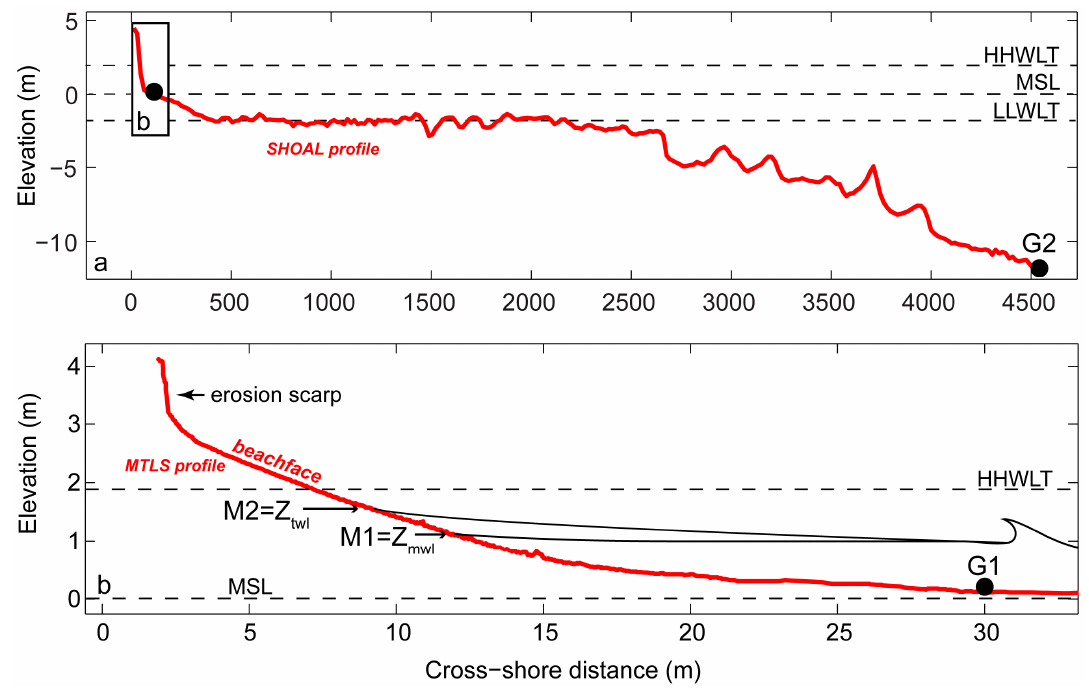
Figure 2. Cross-shore profile (extracted from a shoal survey of 2015 obtain from the Canadian Hydrographic Service, 2015) of Pointe-Lebel beach and location of the in-situ instruments (G1 and G2) ( a ). A focus on the beachface is shown in ( b ) from the MTLS (Mobile Terrestrial Lidar System) survey of 3 August 2016. Elevations associated to higher high water large tides (HHWLT), mean sea levels (MSL) and lower low water large tides (LLWLT) are shown by horizontal dashed lines.